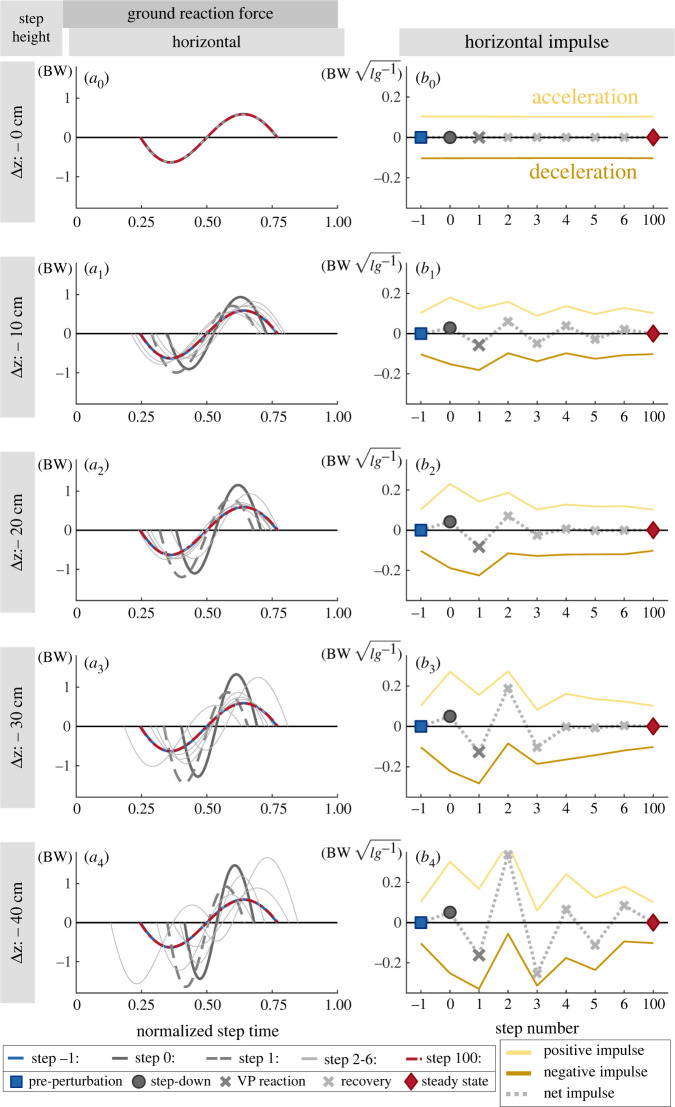
The horizontal ground reaction forces over normalized step time are shown (a0−a4). The peak horizontal GRF increases with the step-down perturbation. The area under this curve is the horizontal impulse, which corresponds to the acceleration and deceleration of the main body (b0−b4). The step-down perturbation at step 0 increases the energy of the system. The increase in energy influences the net horizontal impulse, as the impulse attains a positive value (circles) and causes the body to accelerate forwards. In response, the VP position changes to create net negative impulse in the following step (i.e. step 1, dark cross marker) and decelerates the body. The VP position is adjusted until all the excess energy is removed from the system (cross markers) and the gait reaches to an equilibrium state (diamonds).